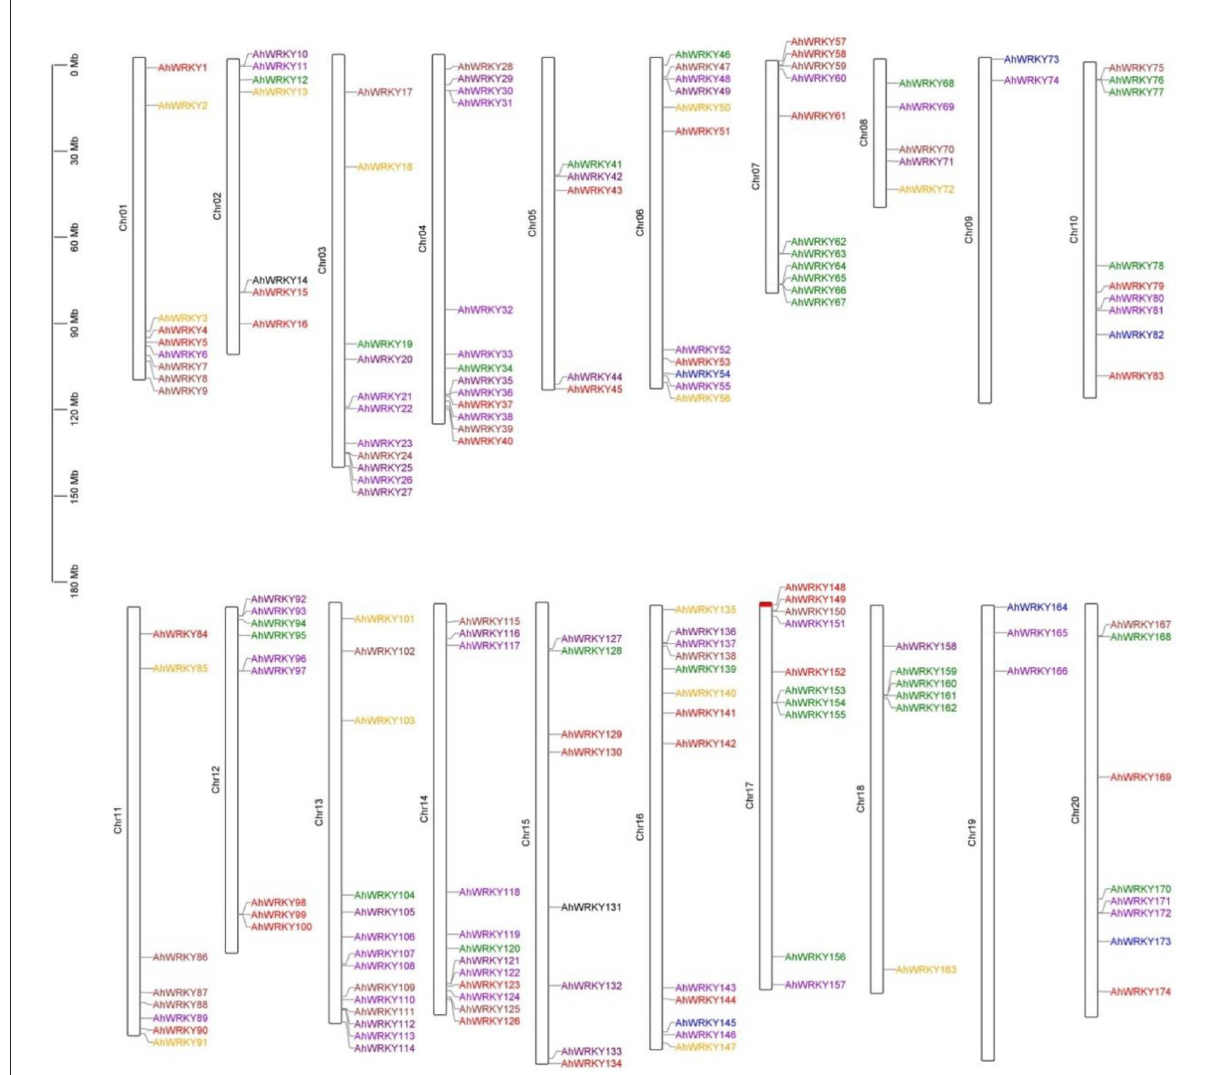
FIGURE2 Chromosome mapping of AhWRKY genes. The scale represents a 30-Mb chromosomal distance. Red, sky blue, brown, DarkViolet, orange, purple, green, and blue indicated groups I, II-a, II-b, II-c, II-d, II-e, III, and IV, respectively.